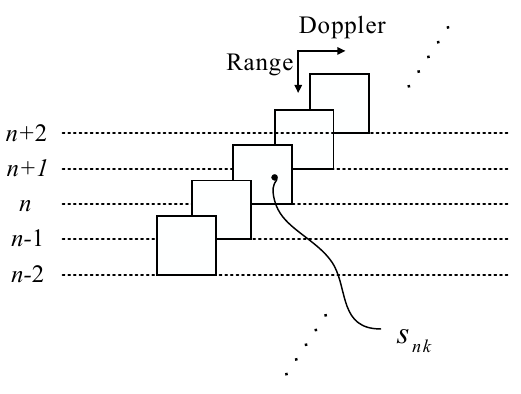
Figure 2. The RD sequence obtained by the receiver.